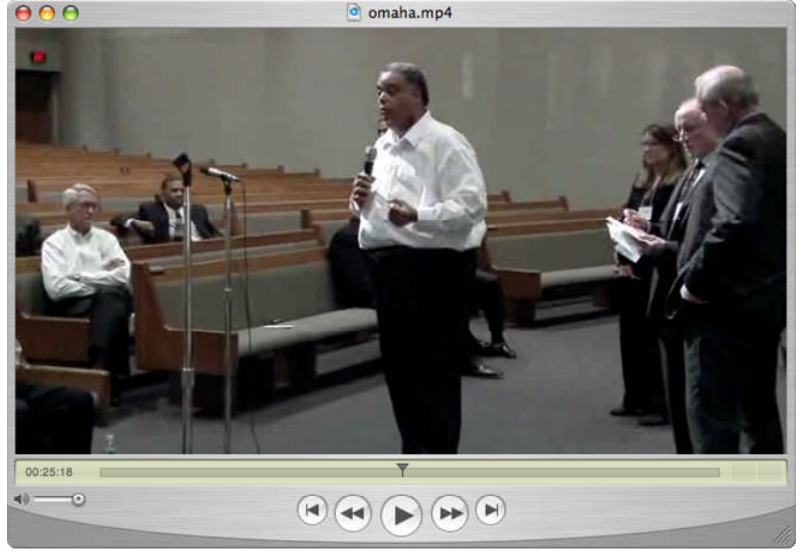
Figure 5: NODP core group forms line in very close proximity and all facing